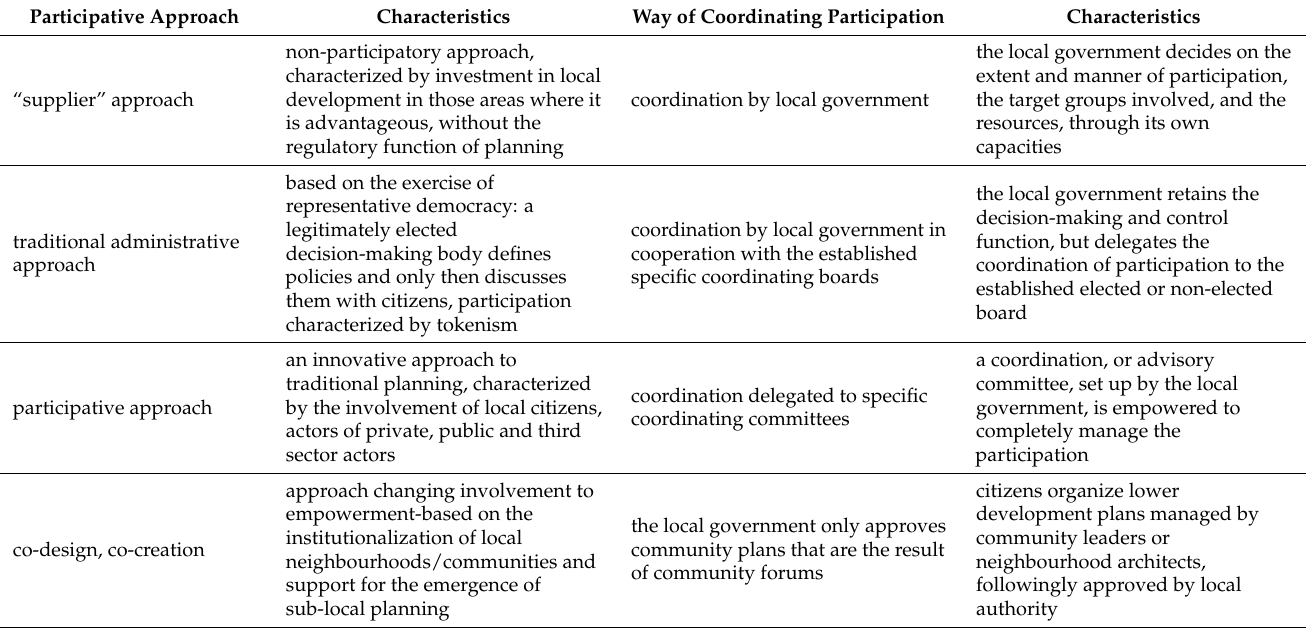
Table 2. An overview of the types of participatory approach and coordination